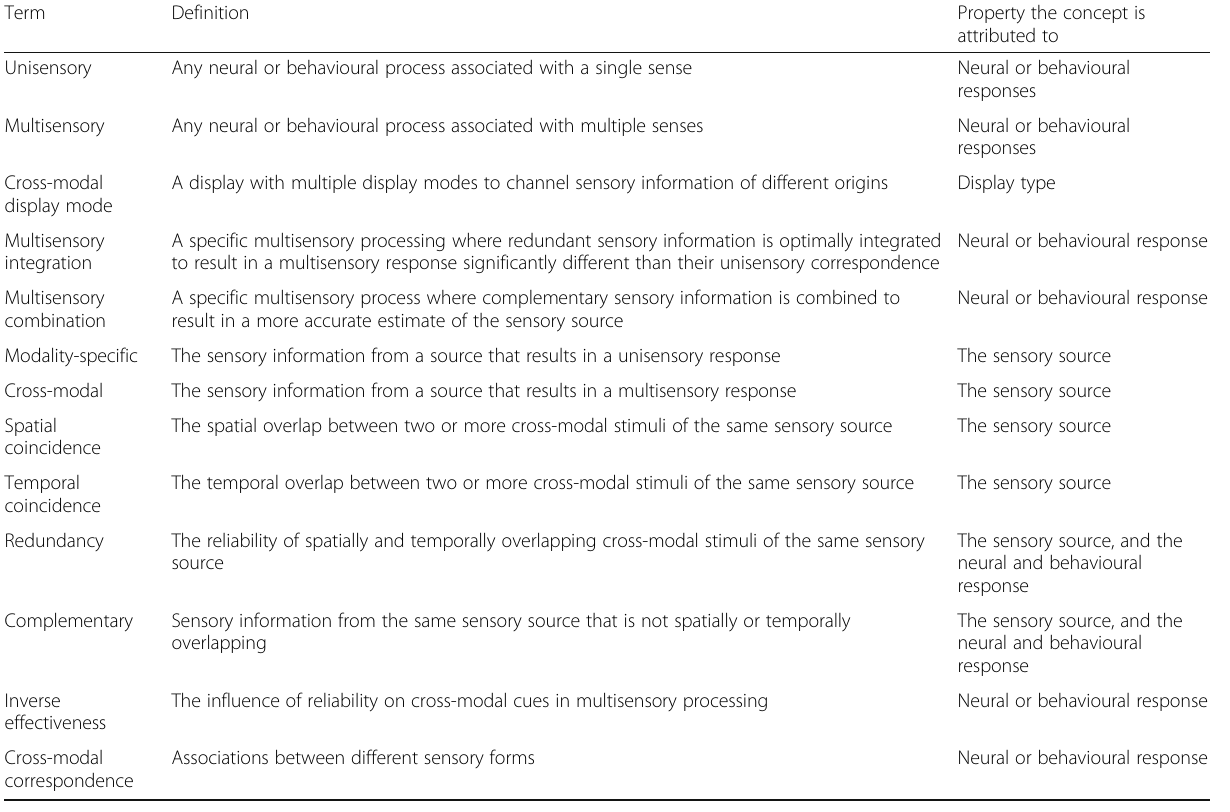
Table 1 Definitions of key terms from cognitive neuroscience studies to describe concepts relating to multisensory processing, as outlined by Stein et al.,